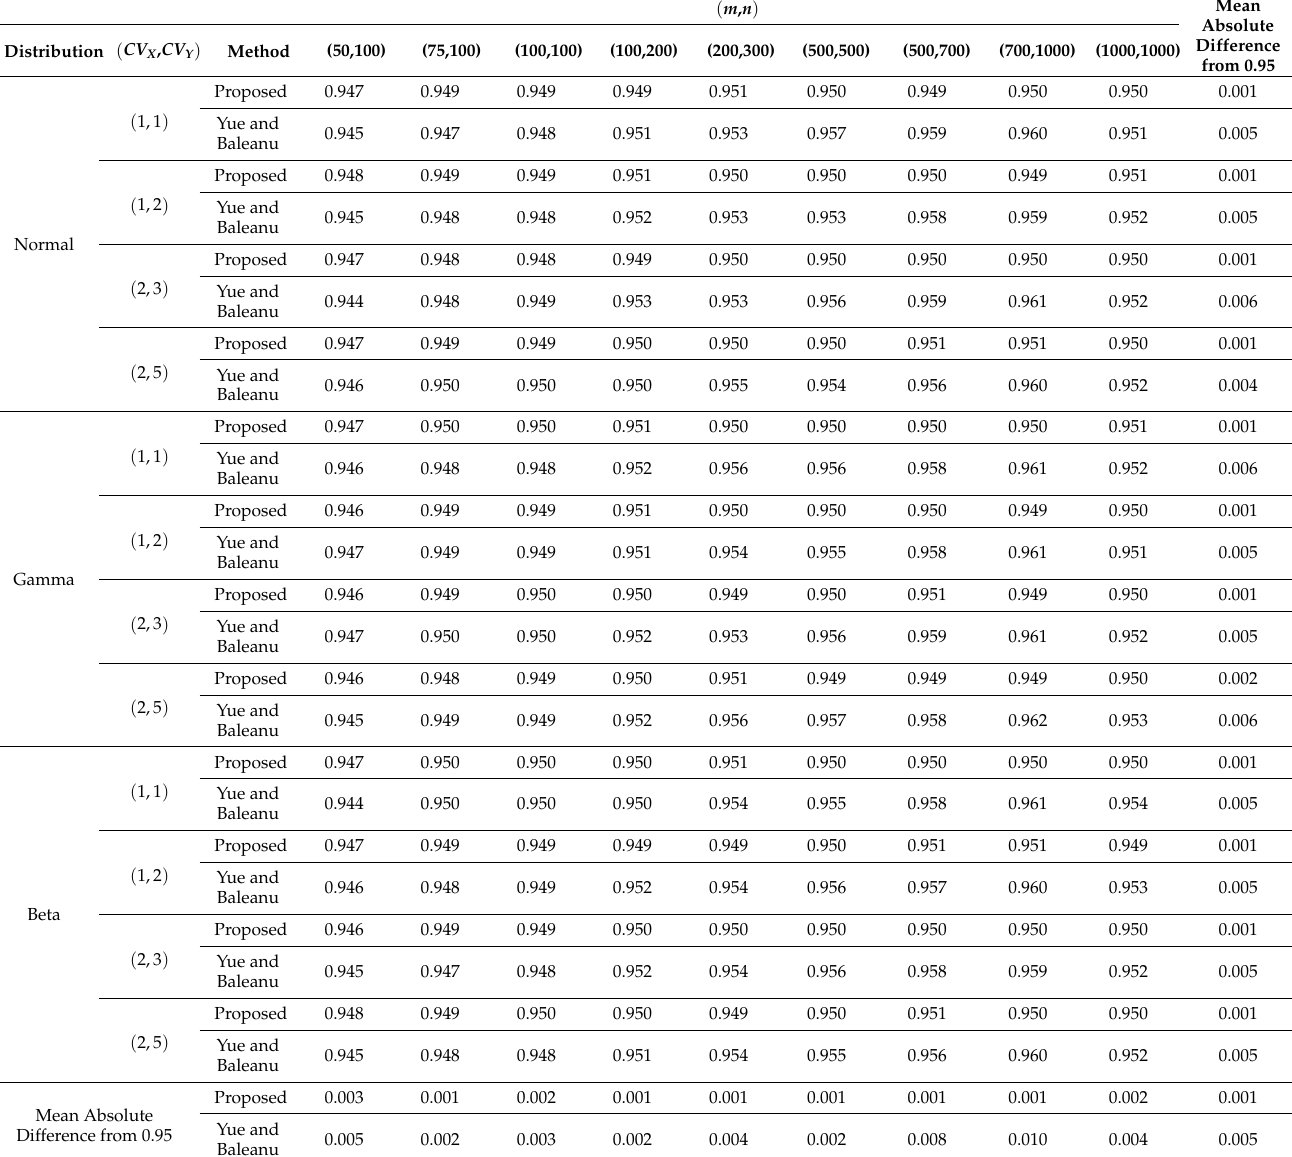
Table 1. The values of CP of the proposed and the Yue and Baleanu [27] methods, for various settings of